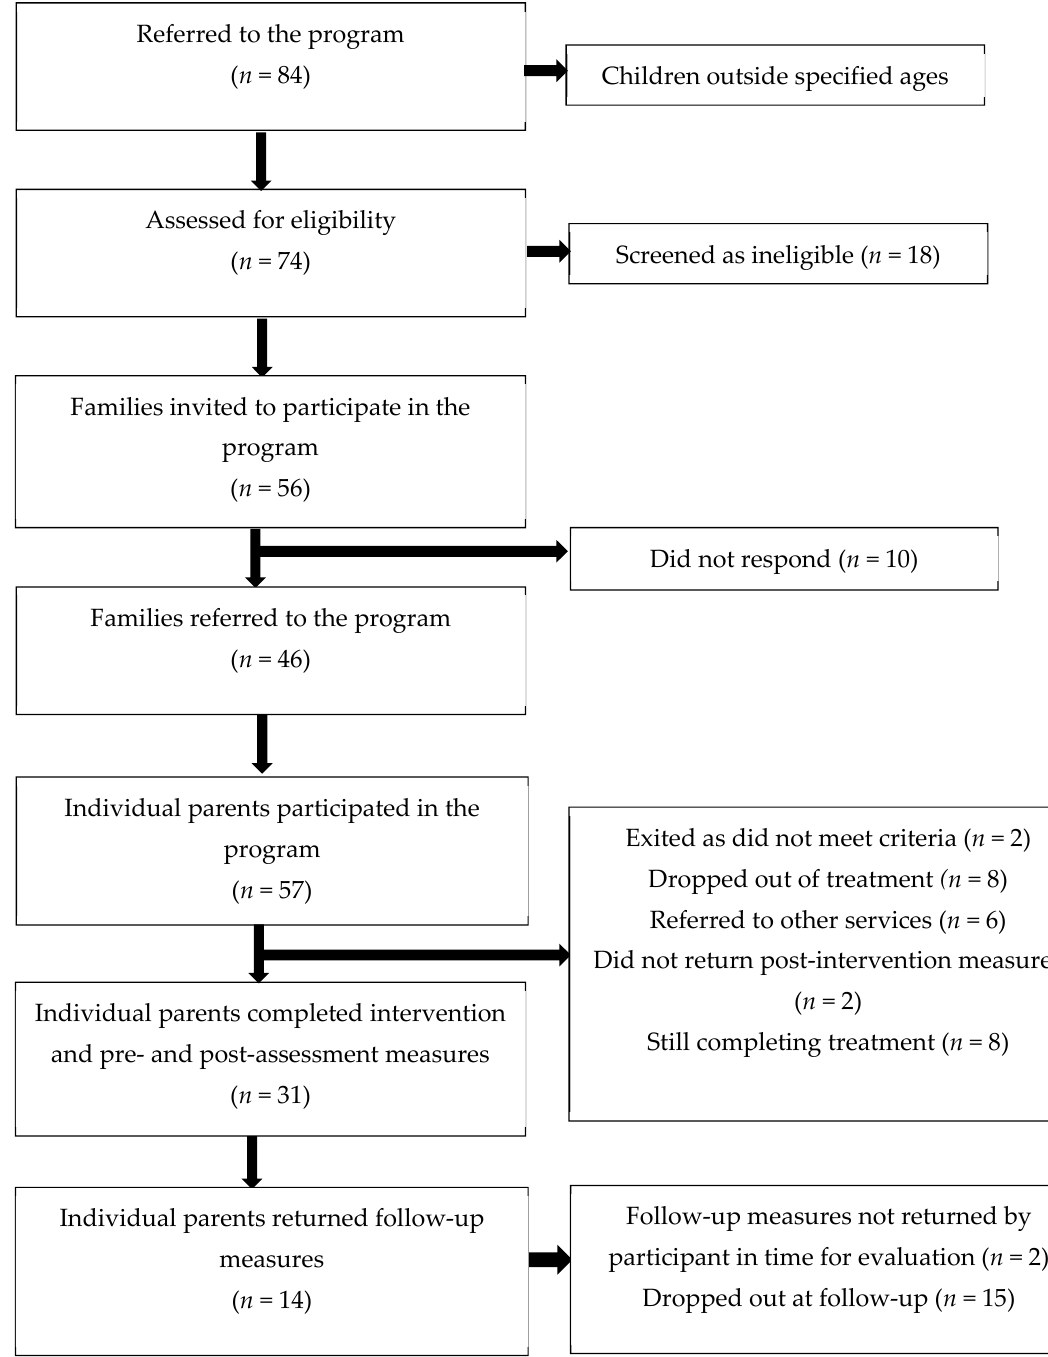
Figure 1. Flowchart for recruitment through screening, pre-assessment, post-assessment, and 3 month follow-up.